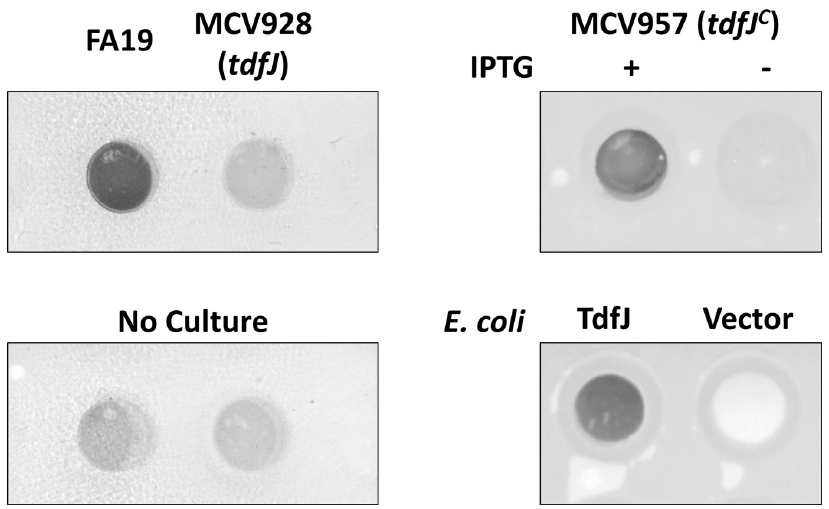
Fig 8. S100A7 binds to both gonococcal and recombinant TdfJ. N . gonorrhoeae strains FA19, MCV928 ( tdfJ ), and MCV957 ( tdfJ c ) with and without IPTG were grown as described in Zn-restricted CDM supplemented with 24 μ M Fe (NO 3 ) 3 for 4 h before being applied to nitrocellulose in a dot blot apparatus at a standardized optical density (top row). E . coli strains containing pVCU313 for TdfJ production or carrying an empty pET-11a vector were grown in LB and induced for 4h before standardizing to the same optical density as used for gonococci and subsequently applied to nitrocellulose (bottom right). Samples were blocked and then probed for 1 h with HRP-labeled S100A7 diluted in blocker before colorimetric development. Wells lacking cells were probed with S100A7-HRP and developed to determine background signal (bottom left). Images are representative of N = 3